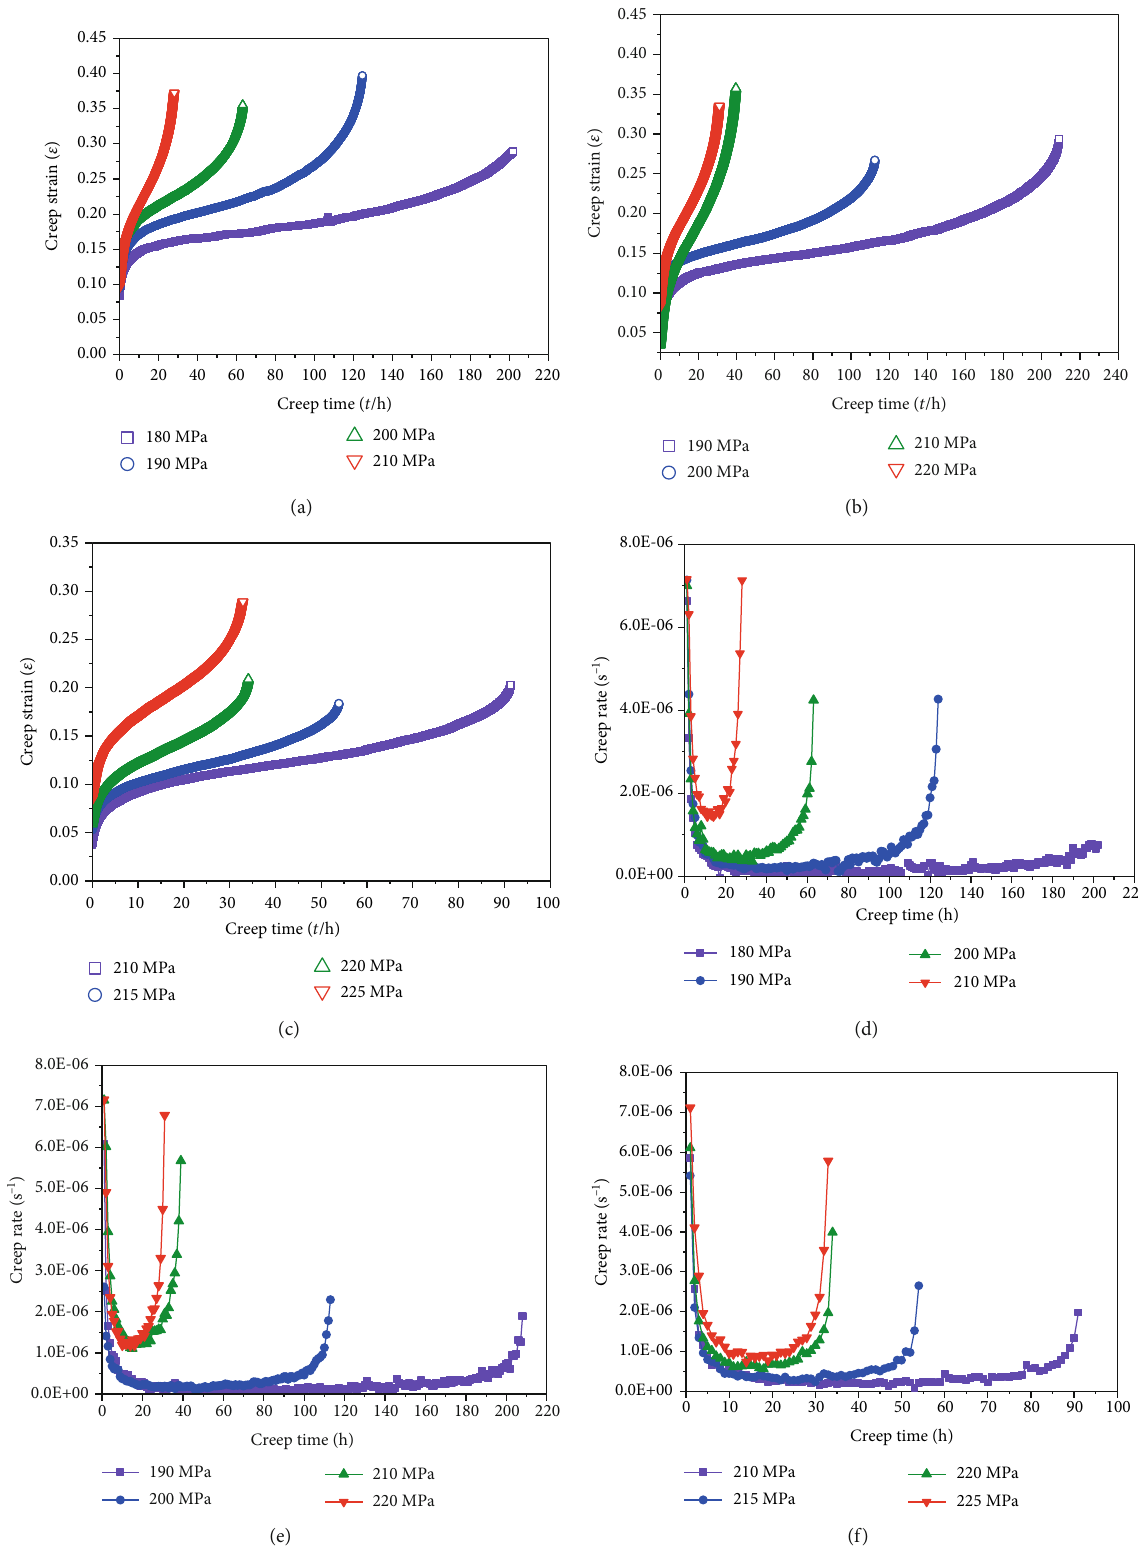
Figure 5: Creep curves and creep rate curves of specimens under di ff erent loading stresses: (a) creep curve of aluminized specimen; (b) creep curve of aluminized specimen with single LSP impact; (c) creep curve of aluminized specimen with three LSP impacts; (d) creep rate curve of aluminized specimen; (e) creep rate curve of aluminized specimen with single LSP impact; and (f) creep rate curve of aluminized specimen with three LSP